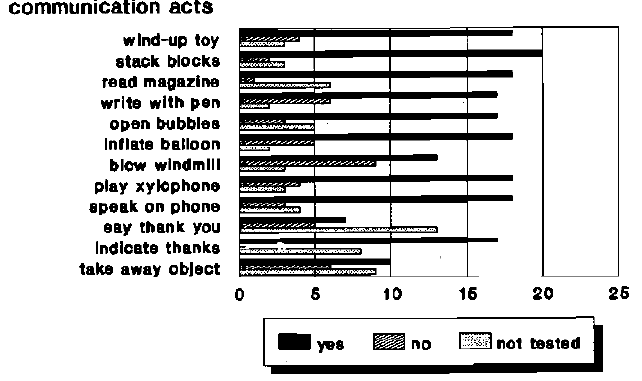
Figure 6: Frequencies for tester-child pragmatic